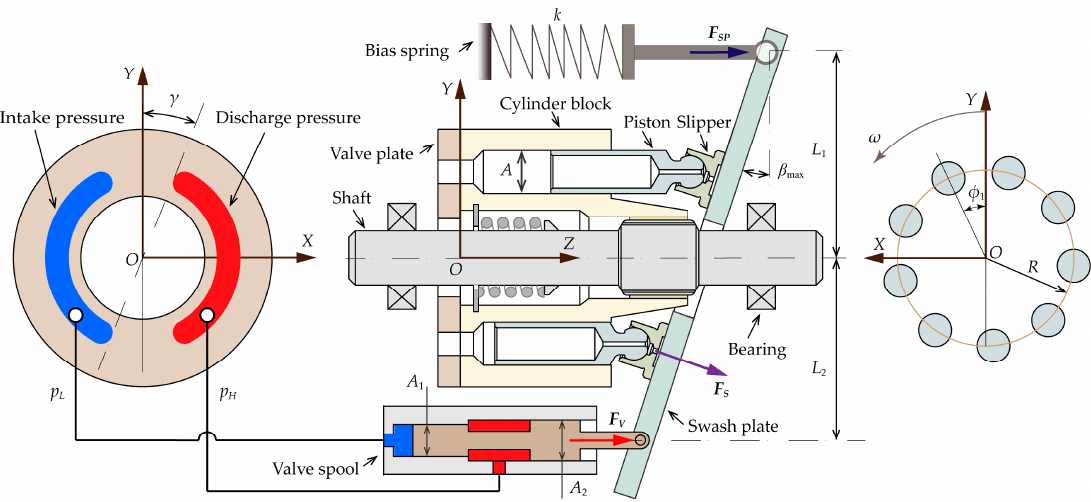
Figure 3. Schematic of the EHA pump with a load-sensing mechanism.